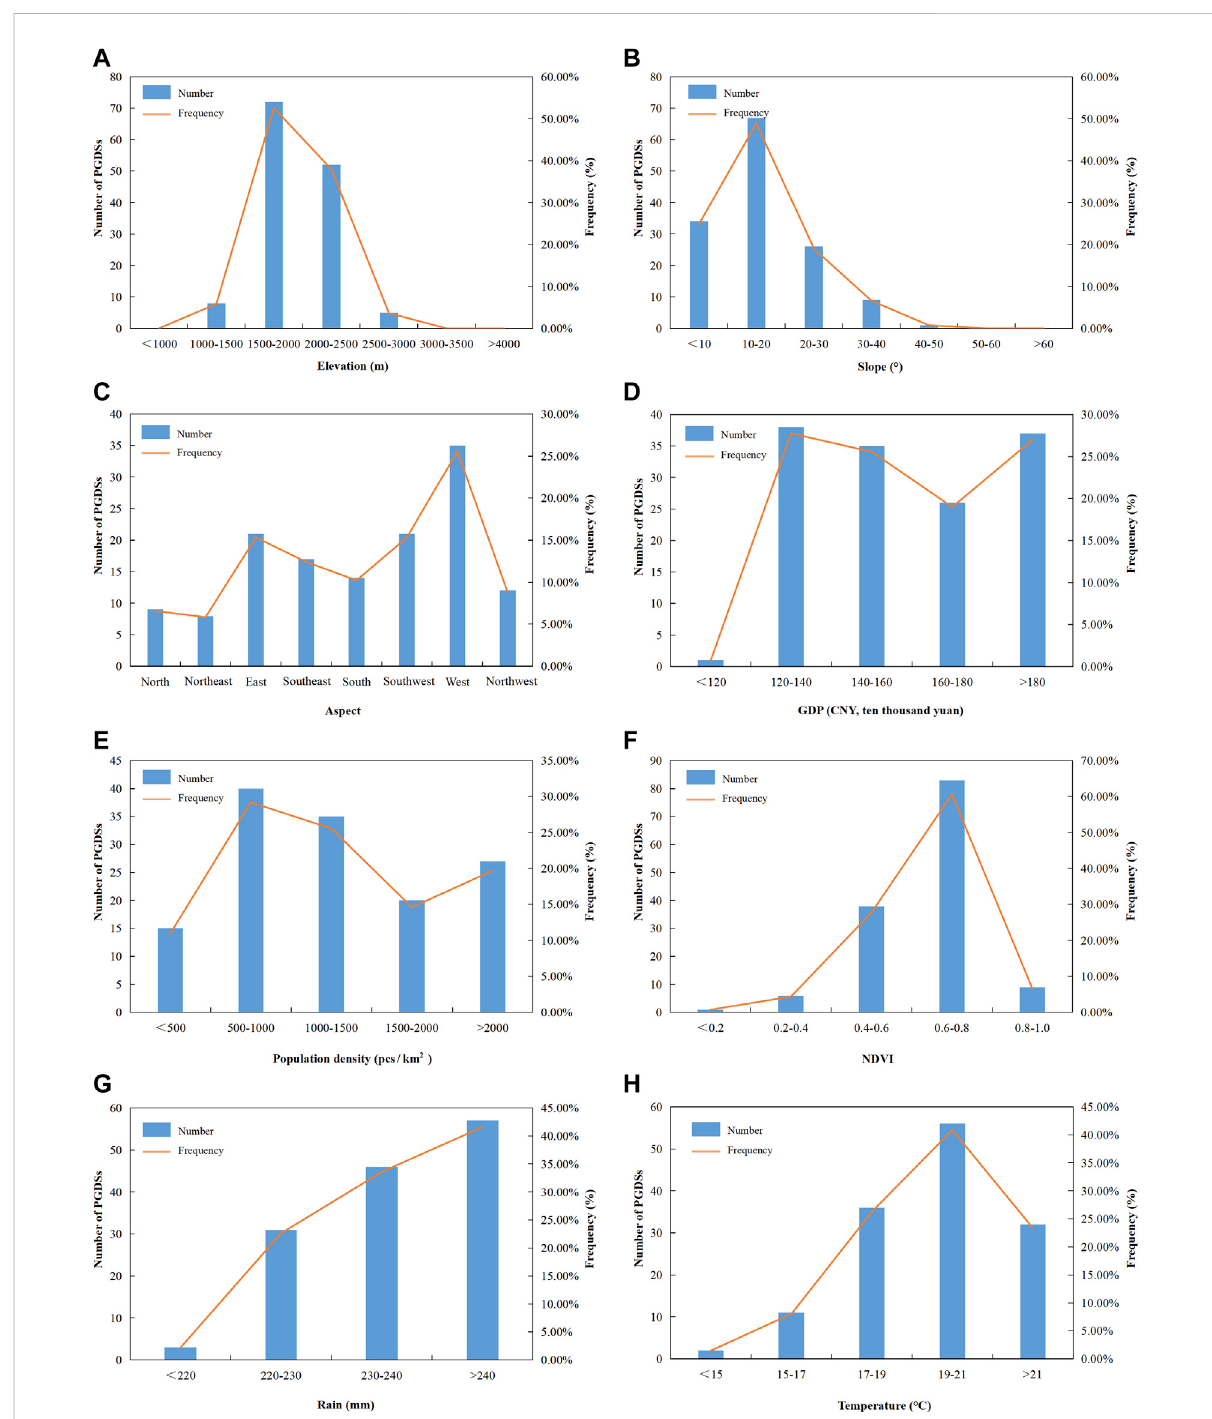
FIGURE 8 Statistics analysis of